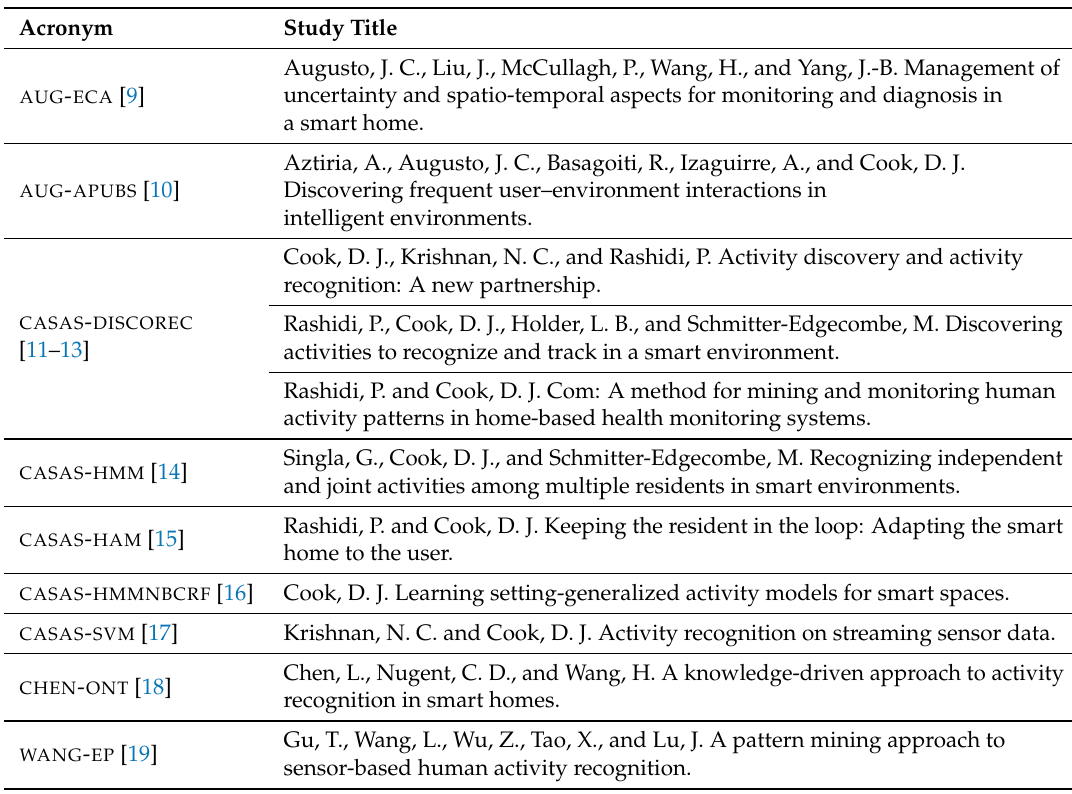
Table 1. Selected